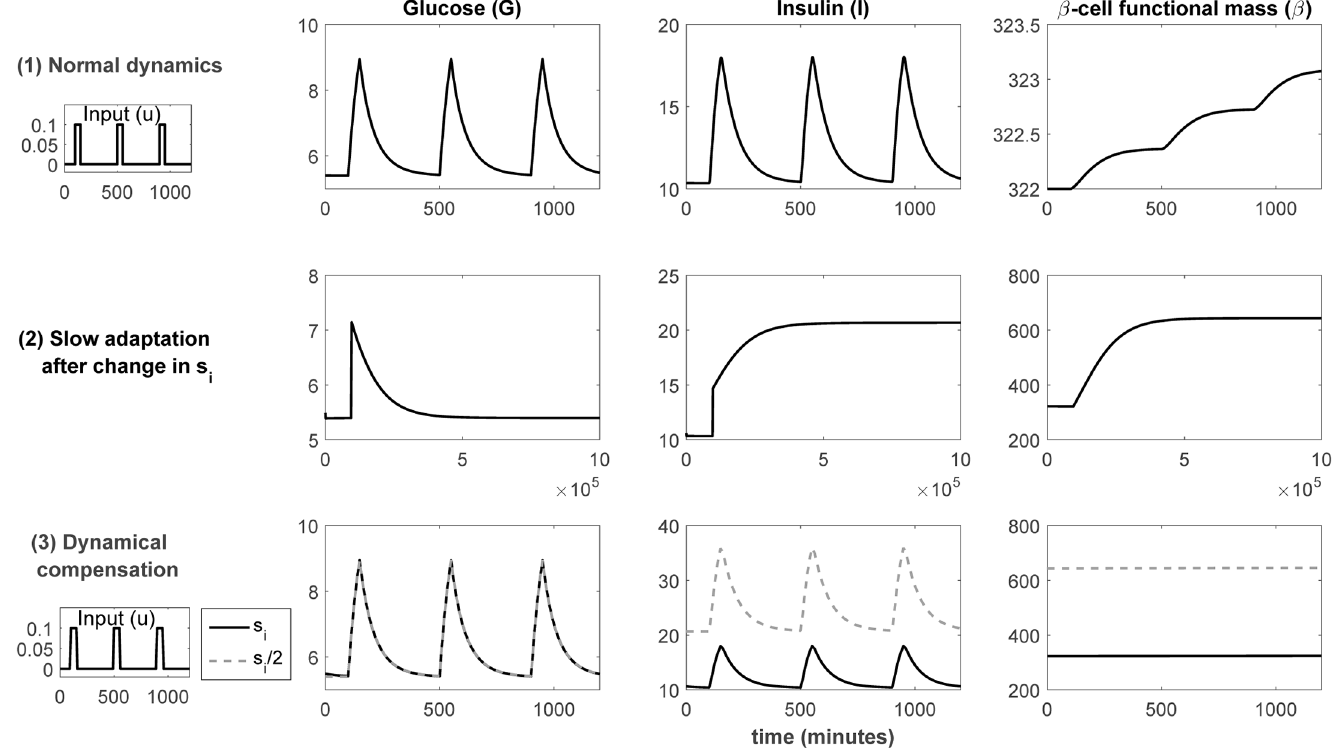
Fig 2. Illustration of the phenomenon of dynamical compensation in a physiological circuit. The upper row shows the normalbehaviourof the β IG model for a given value of the s i parameter. The second row shows the evolutionof the steady state after a changein the value of s i . After a long adaptation period, which can take months, a new steady state is reached(note that in the plots in this row no external inputs are applied,for clarity of visualization; if they were, periodicpeaks similar to the ones in the first and third rows would appearsuperimposed on the plotted curves). Then, as shown in the third row, the responseof the glucoseconcentration for the new parameter value is the same as the initial one (this does not happenfor insulinand β -cellmass).